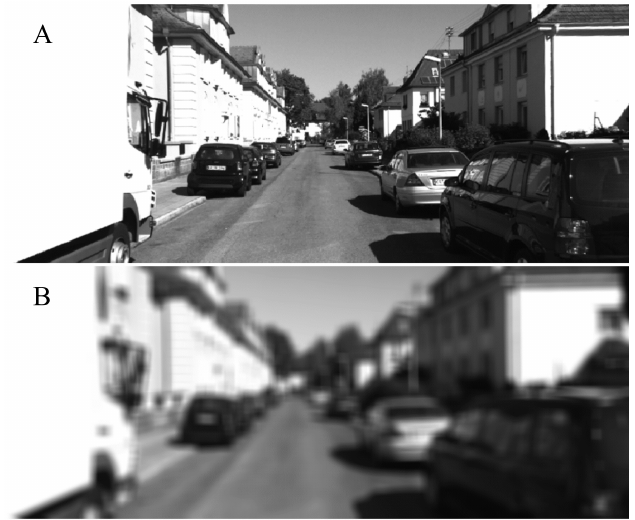
Figure 2. Sample image from the original ( A ) and blurred ( B ) KITTI dataset (sequence 07). The original image was blurred using a gaussian filter with a patch size of 12 pixels and a standard deviation of 2.15 pixels 241 in both